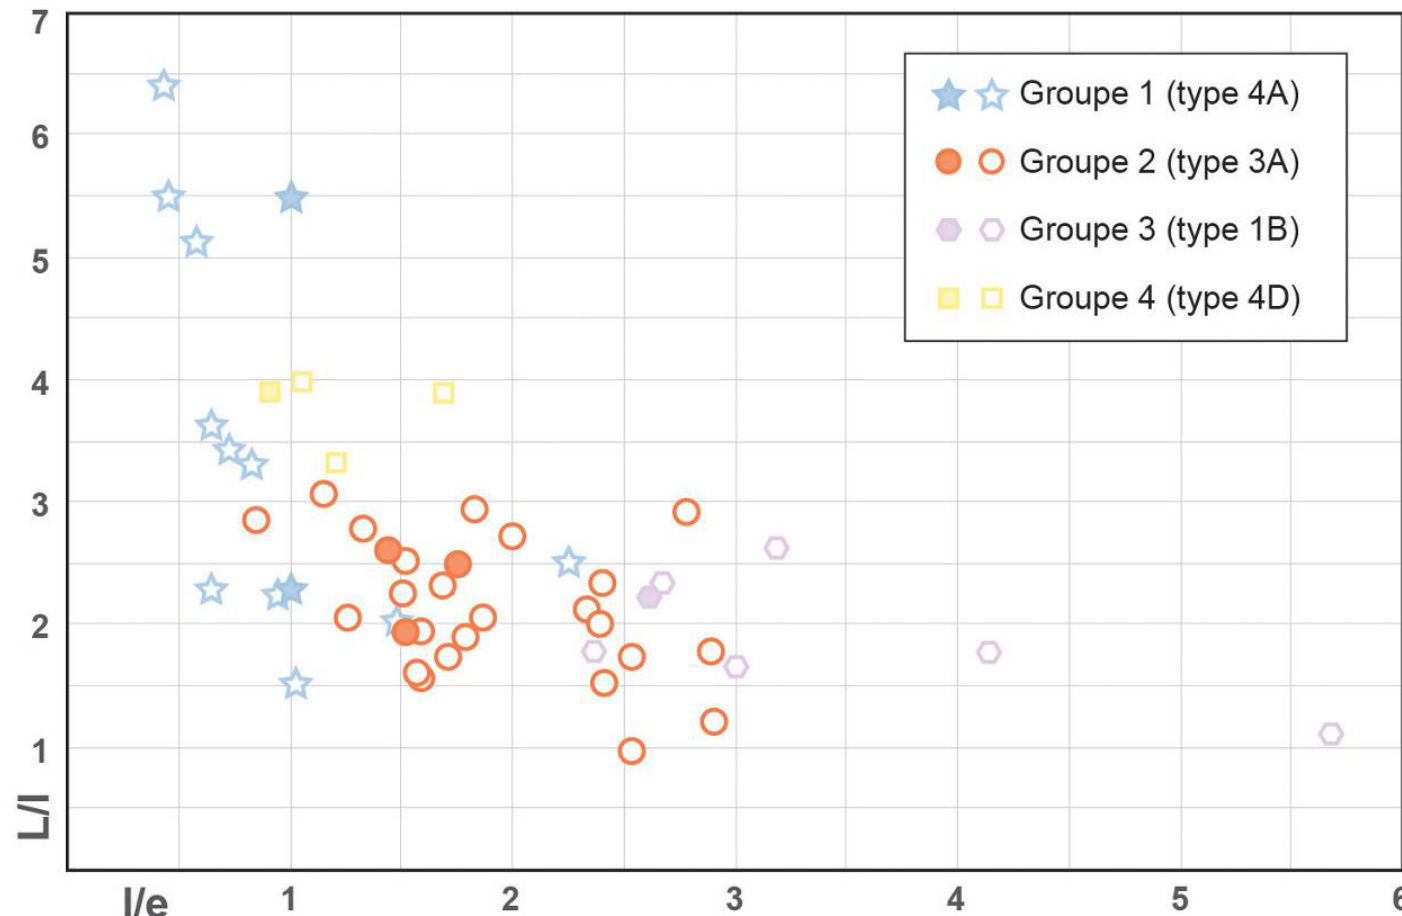
Figure 12. Morphométrie des produits façonnés à Tanataetea (les préformes abouties sont représentées par les symboles pleins et les ébauches par les symboles vides). Figure 12. Morphometric of roughouts and preforms at Tanataetea (finished preforms represented by full symbols, roughouts by empty